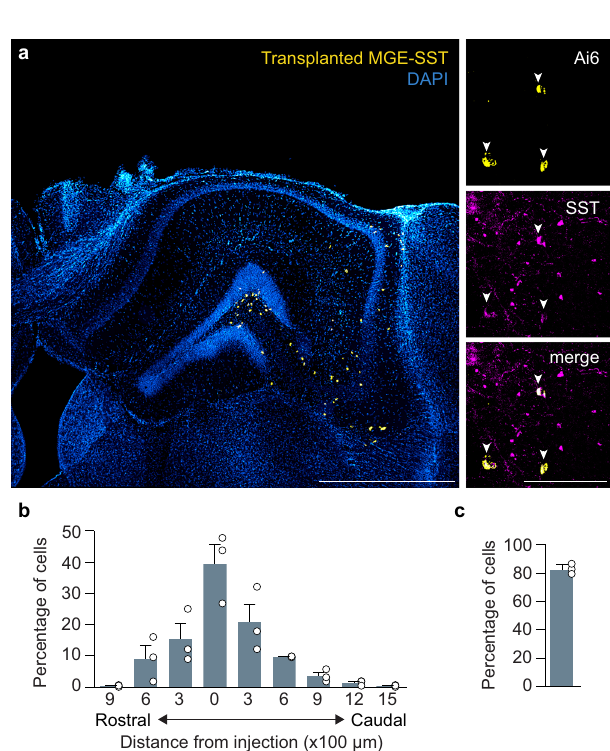
Fig. 7 Transplanted SST interneurons integrate into brain-injured hippocampus. a Left: Coronal section of dorsal hippocampus fi ve weeks after transplantation labeled for Ai6-expressing transplanted interneurons (yellow) and DAPI (blue). Representative animal from n = 3 mice. Scale bar, 1 mm. Right: Ai6-expressing neurons (yellow) co-labeled for somatostatin (magenta). Scale bar, 100 μ m. b Distribution of transplanted SST interneurons 35 DAT, n = 3 mice. c Proportion of Ai6-expressing cells that expressed somatostatin, n = 3 mice. Error bars, s.e.m. See also Supplementary Fig. 15. Source data are provided as a Source Data fi